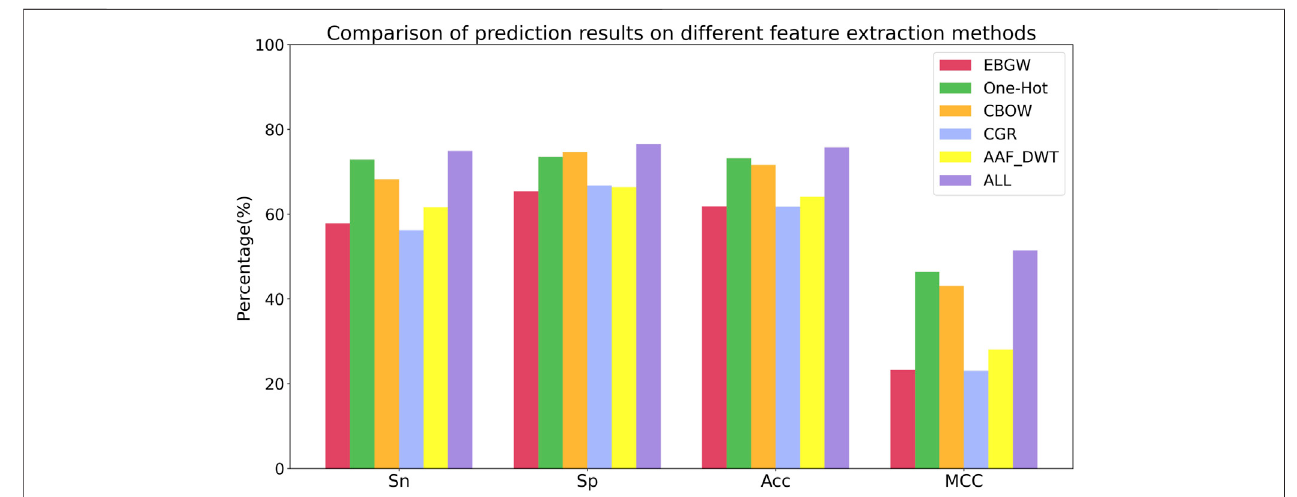
FIGURE 7 | Comparison of prediction results on different feature extraction methods.